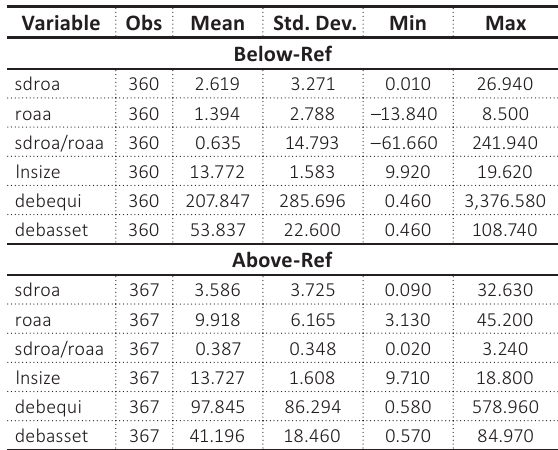
Table 2. Statistics of two groups of companies classified based on the reference point of each